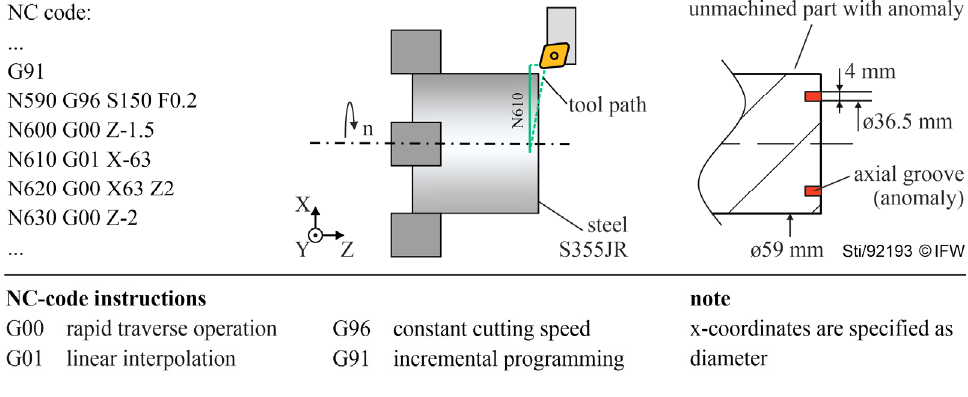
Figure 1. Experimental machining. Table 2. Examined machine